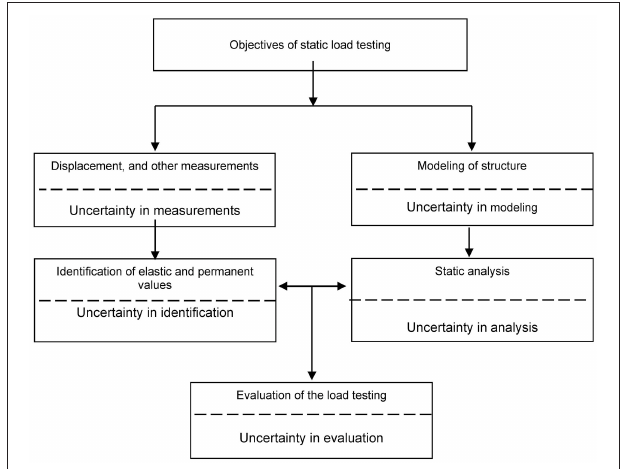
FIGURE 1 | Block diagram of static test loading process during diagnostic tests of a bridge structure; developed by analogy with the diagram from the norm (ISO 18649, 2004).